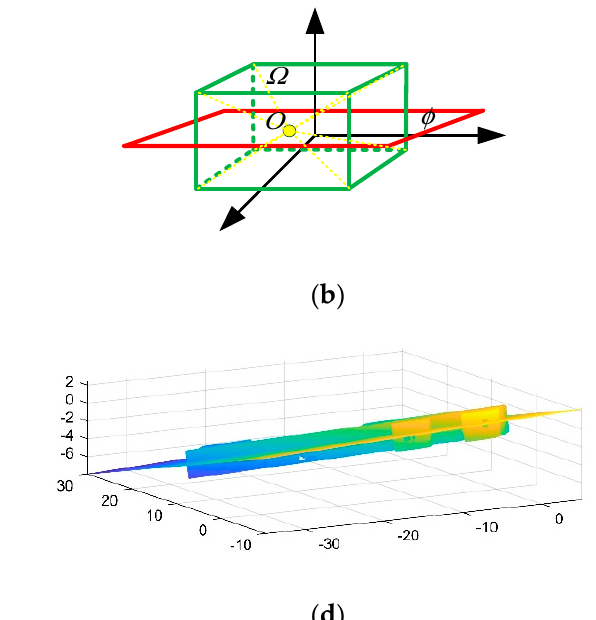
φ Ο is the average value of data; is the plane determined by the normal vector and